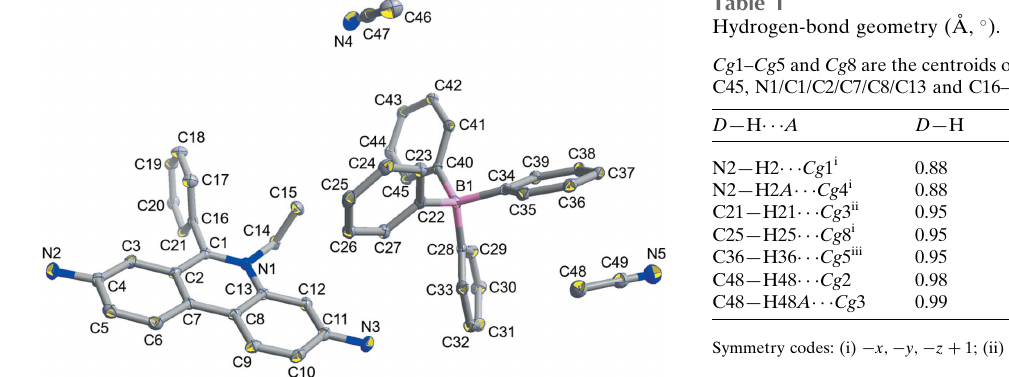
Table 1 Hydrogen-bond geometry (A˚ , (cid:3) ).